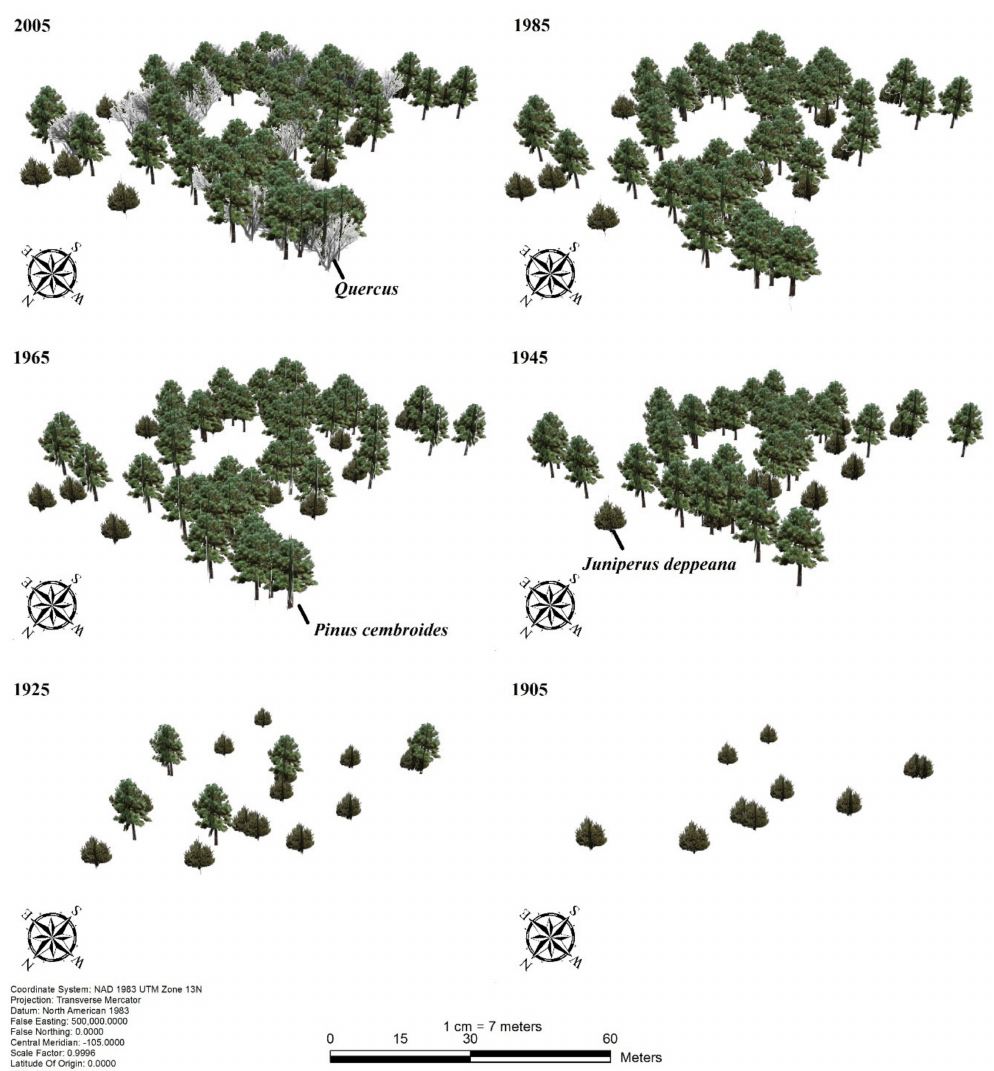
Figure 2. Spatial pattern of Mexican piñon ( Pinus cembroides var. cembroides Zucc.), alligator juniper ( Juniperus deppeana var. deppeana Steud.), and oak species ( Quercus spp. L.) within study site 1 in 1905 through